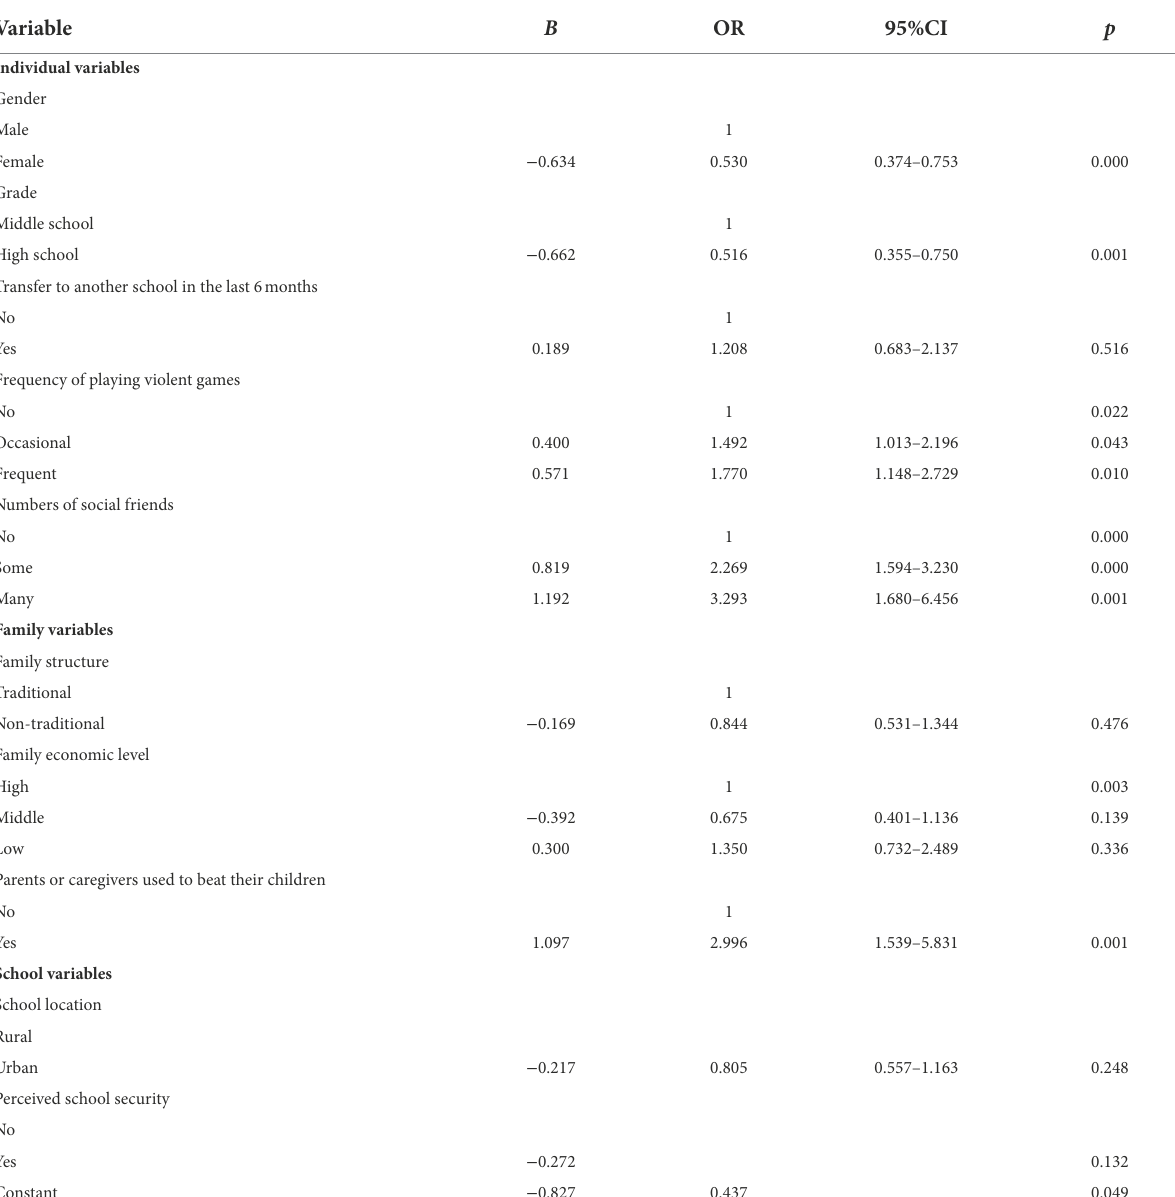
TABLE 4 Binary regression analysis